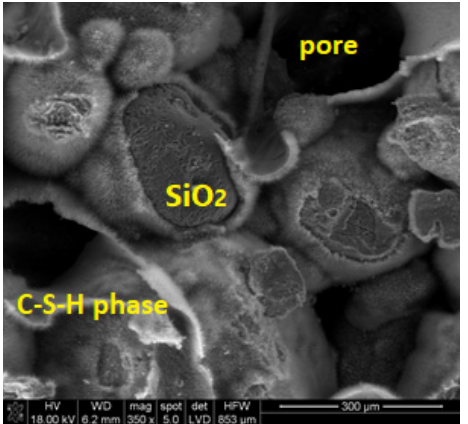
Figure 8. SEM image showing microstructure of ‘artificial stone’, i.e., brick/mortar, which was made of natural quartz sand SiO 2 (90% by weight), lime CaO (7% by weight), and water H 2 O (about 3% by weight); magnification 350×.